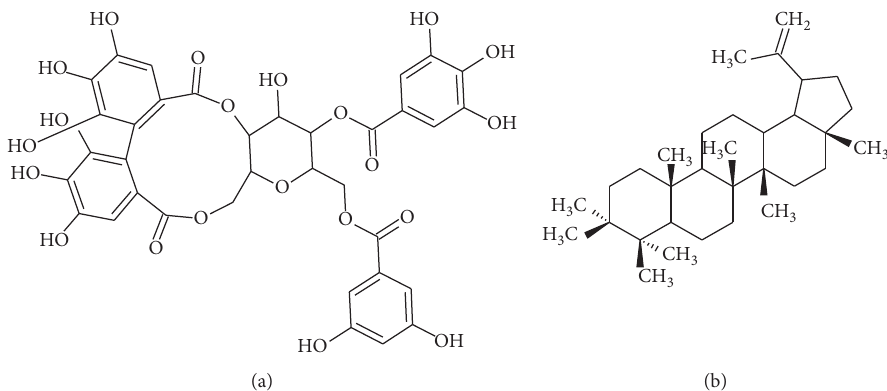
Figure 4: The chemical structure of (a) 1, 2-di-O-galloyl-3-O-digalloyl-4, 6-O-(S)-hexahydroxydiphenoyl-3-I β -glucose, the chemical composition of cajuput fruits, and (b) the general structure of lupene which are the chemical composition of the leaves.